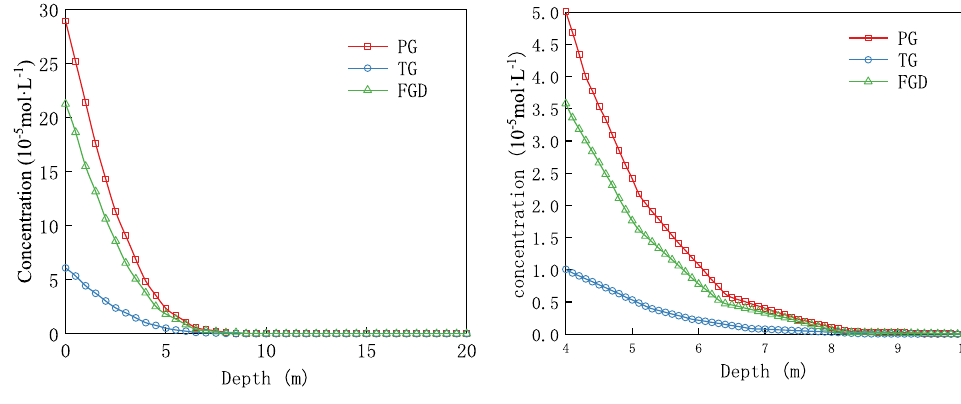
Fig. 7 Zn concentration distributions at different depths along the mine floor direction at 200a (10 −5